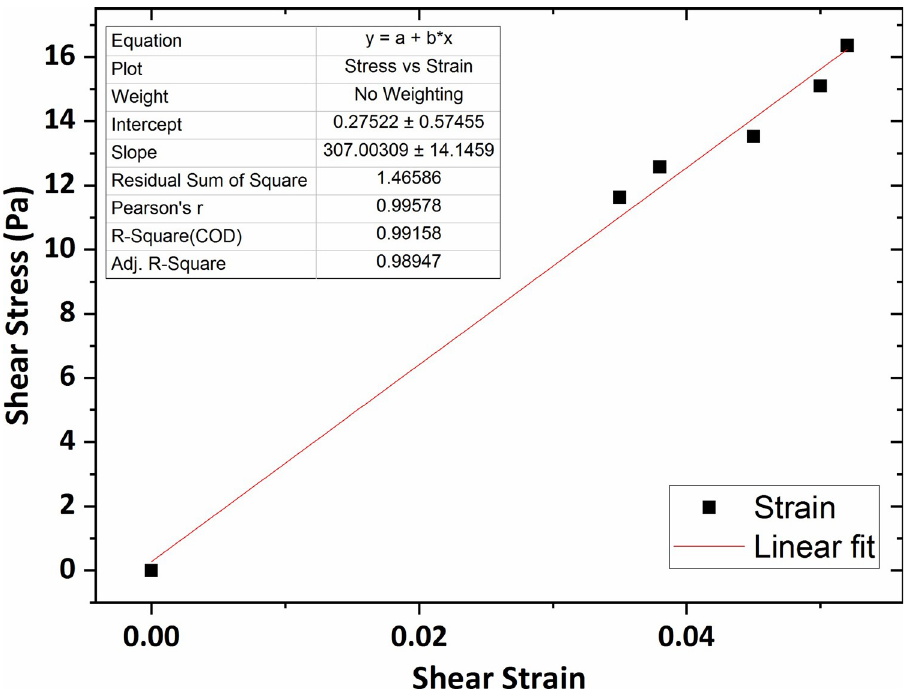
Fig 8. The graph of shear stress versus shear strain for the agarose gel of 0.3 wt % percent concentration.